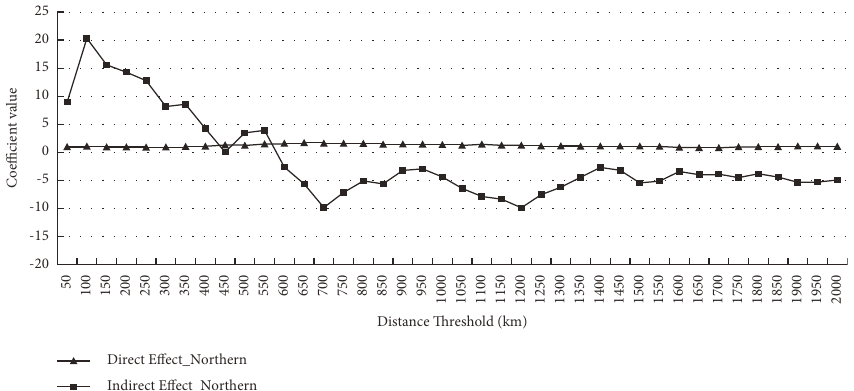
Figure 10: Spatial trends of the impact of the northern region’s digital economy on urban